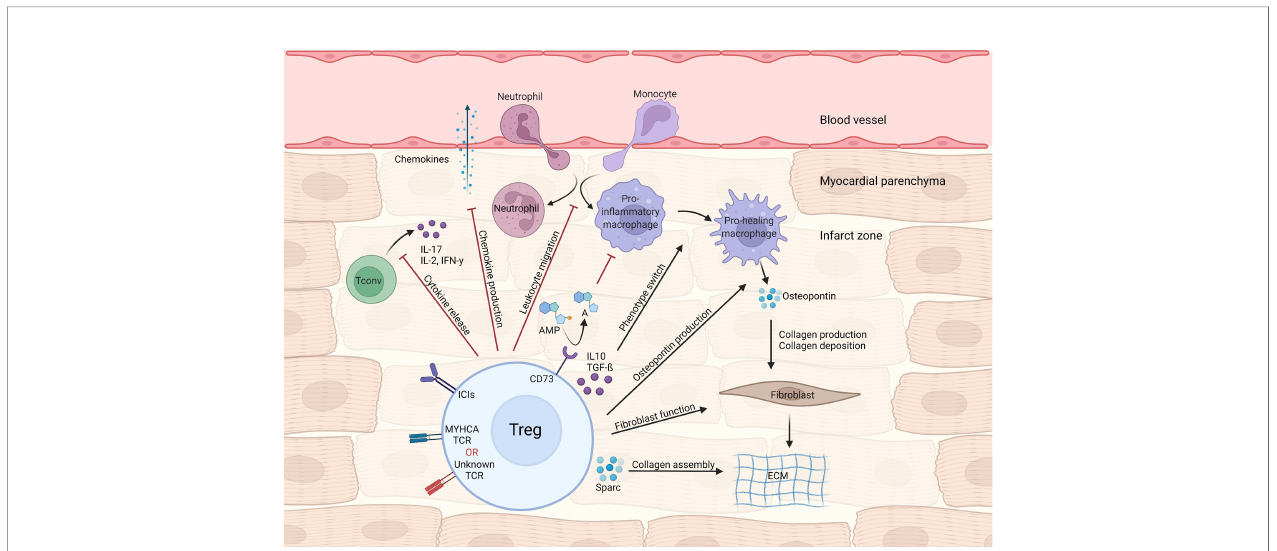
FIGURE 1 | Treg-mediated effects in myocardial repair and in fl ammation after infarction. Tregs control local immune responses through a multitude of mechanisms, including inhibiting both canonical T H 1/T H 17 cytokine production and leukocyte migration. Treg cytokines (e.g. IL-10 and TGF- b ) and purinergic metabolism products may modulate macrophage polarization towards a pro-healing/reparative phenotype. In addition, Tregs contribute to fi broblast activation and steady collagen deposition in the infarcted